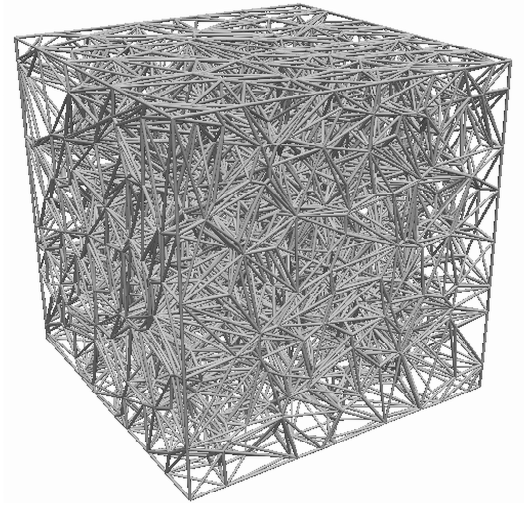
Figure 2. Carbon fibers framework of a GDL sample.